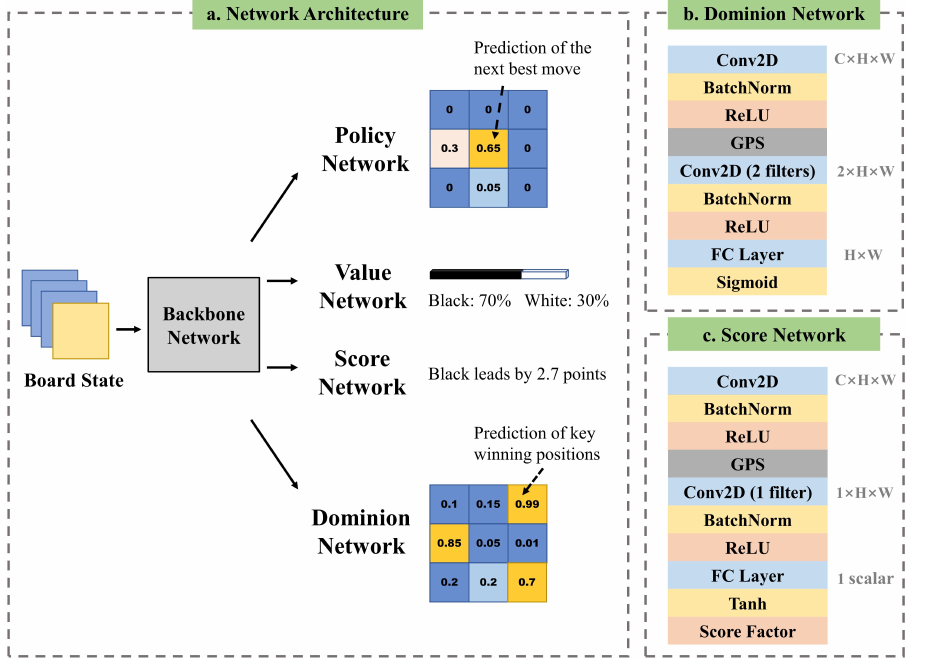
Figure 4. ( a ) Multitask learning network structure. ( b ) Illustration of dominion head. ( c ) Illustration of the score head. Except for the policy head and value head, which are also used in AlphaZero, we added score head and dominion head to evaluate the gap of the performance of two players and the key winning position, respectively. The two additional heads can effectively help the NoGoZero+ agent have insight into the game state and make full use of self-play data because of the more detailed